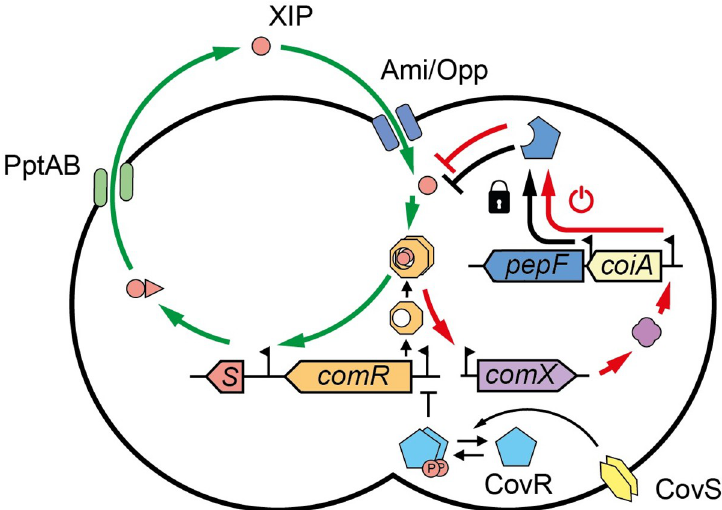
Fig 7. Model of competence regulation integrating the PepF-mediated shut-off in S . salivarius . Upon CovRS repression release, ComR reaches a threshold concentration allowing the activation of a positive feedback loop (green arrows). The positive loop is triggered by XIP binding to ComR, producing the ComR•XIP complex which activate comS transcription. ComS is then exported by the transporter PptAB and maturated. The mature XIP pheromone can then enter the cell by the oligopeptide generic transporter Ami/Opp and bind ComR to enhance the loop. This activation can take place if XIP levels are sufficient to saturate the activity of PepF at native expression (locker icon). In parallel, the ComR•XIP complex will trigger the transcription of comX , encoding the central regulator of competence. This will activate all the late genes necessary for natural transformation including the coiA-pepF operon. PepF accumulation will result in XIP degradation, generating a negative feedback-loop (red arrows, power-off icon) on the ComRS system, ultimately leading to competence